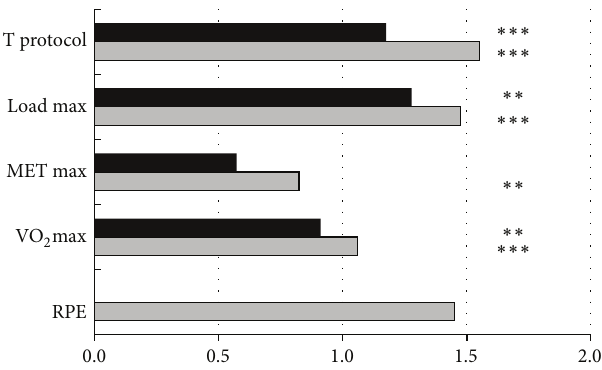
Figure 1: Rate of changes of physical fitness indices after Active Leisure Time Programme (black bars) and Prevent Falls in the Elderly Programme (grey bars), compared to baseline. Note: values are mean normalised outcomes. T protocol: time of exercise in protocol; load max: maximal tolerated load in exercise protocol expressed in Watt; MET max: maximal tolerated load in exercise protocolexpressedinmetabolicequivalentunits;VO 2 max:maximal oxygen consumption; RPE: rate of perceived exertion at the end